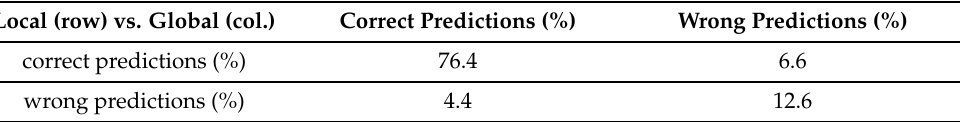
Table 6. Correct vs. wrong predictions (joint models). Local (row) vs. Global